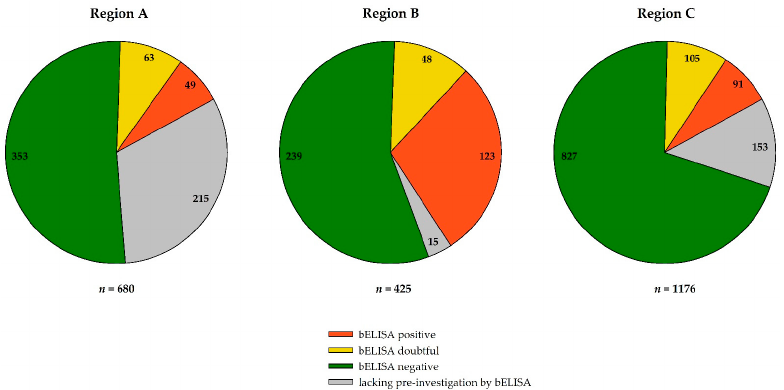
Figure 3. Distribution of blocking ELISA (bELISA) results across the three different sample regions (A–C) of Germany in 2019–2020. In the pie charts, the negative bELISA results are depicted in green, the reactive but doubtful results in yellow, and positive results in orange. The grey segments represent samples for which an initial bELISA screening was not possible due to small sample volume. Virus neutralization assays with reactive bELISA sera ( n = 479), as well as with sera lacking prior bELISA testing ( n = 383), revealed flavivirus species-specific reactivities and allowed an estimation of the overall seroprevalences for WNV and USUV in the three sample regions in 2019 and 2020. For USUV, the seroprevalence in region A was 4.13% (95% CI: 2.21 – 6.95) in 2019 followed by 4.11% (95% CI: 2.31 – 6.69) in 2020. In region B, the seroprevalence was 3.11% (95% CI: 1.01 – 7.10) in 2019 followed by a moderate increase to